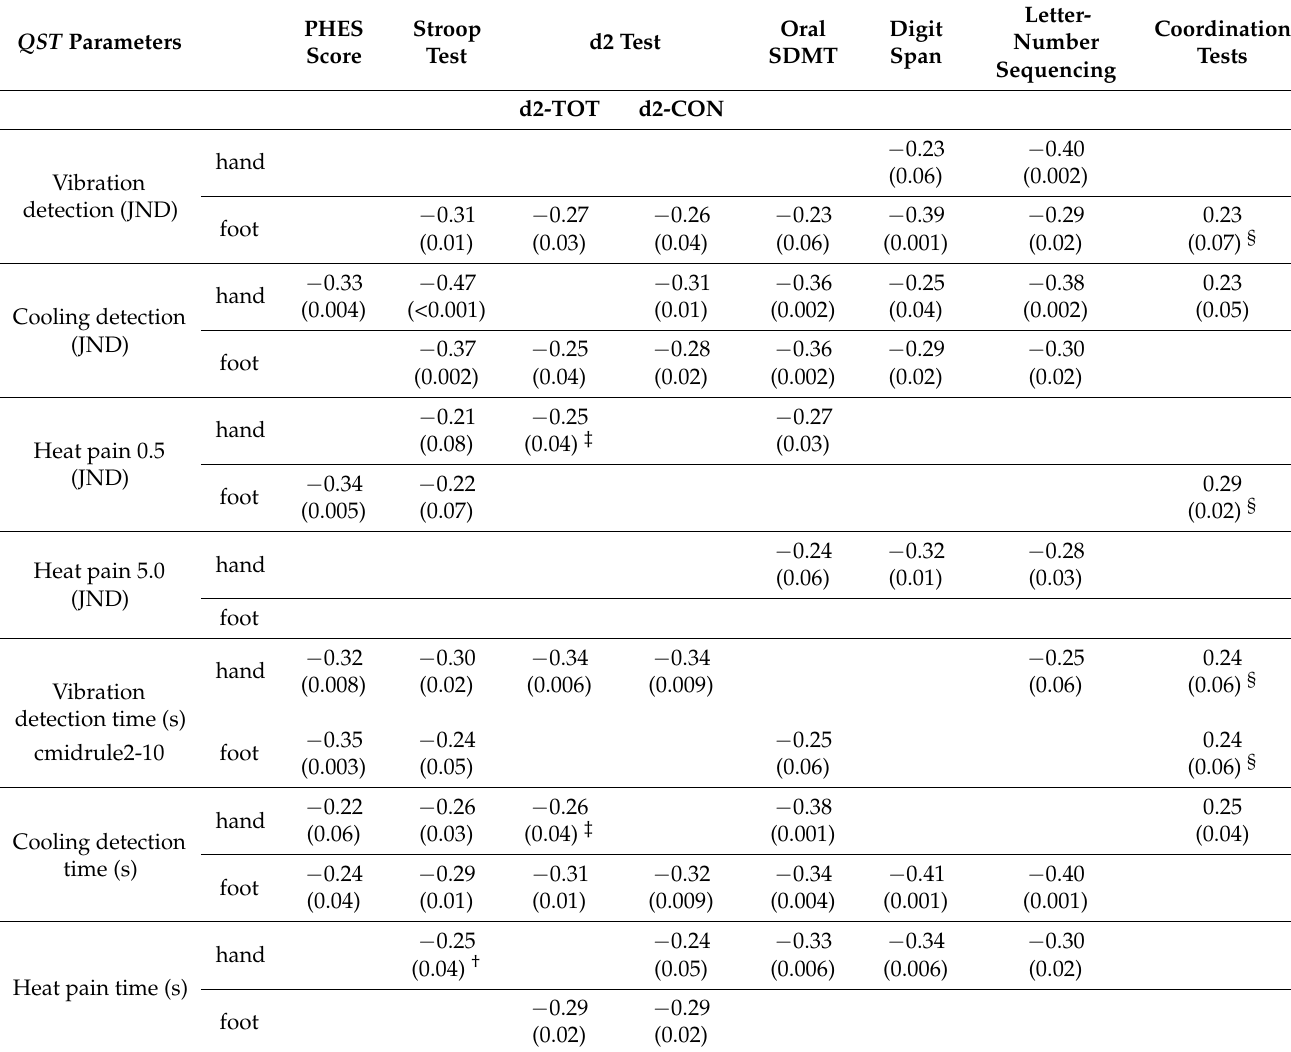
The r values ( p -values) of the Pearson correlation analysis are shown. Significant and near-significant correlations are shown. Values for Stroop test are for Incongruent task, except for ( † ), which are for Neutral task. ‡ Values for d2-TR, Total number of characters processed; § values for visual-motor coordination test; values for bimanual coordination test. QST: quantitative sensory test; JND: just noticeable differences; s: seconds; PHES: Psychometric Hepatic Encephalopathy Score; d2 test: TOT: Total correctly processed; CON: Concentration performance; Oral SDMT: Symbol digit modalities test (oral